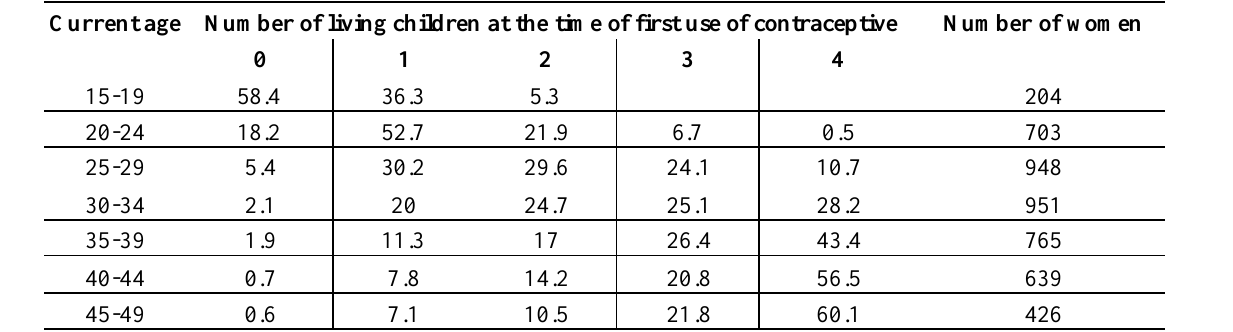
Source: Nepal Demographic and Health Survey 2001 table